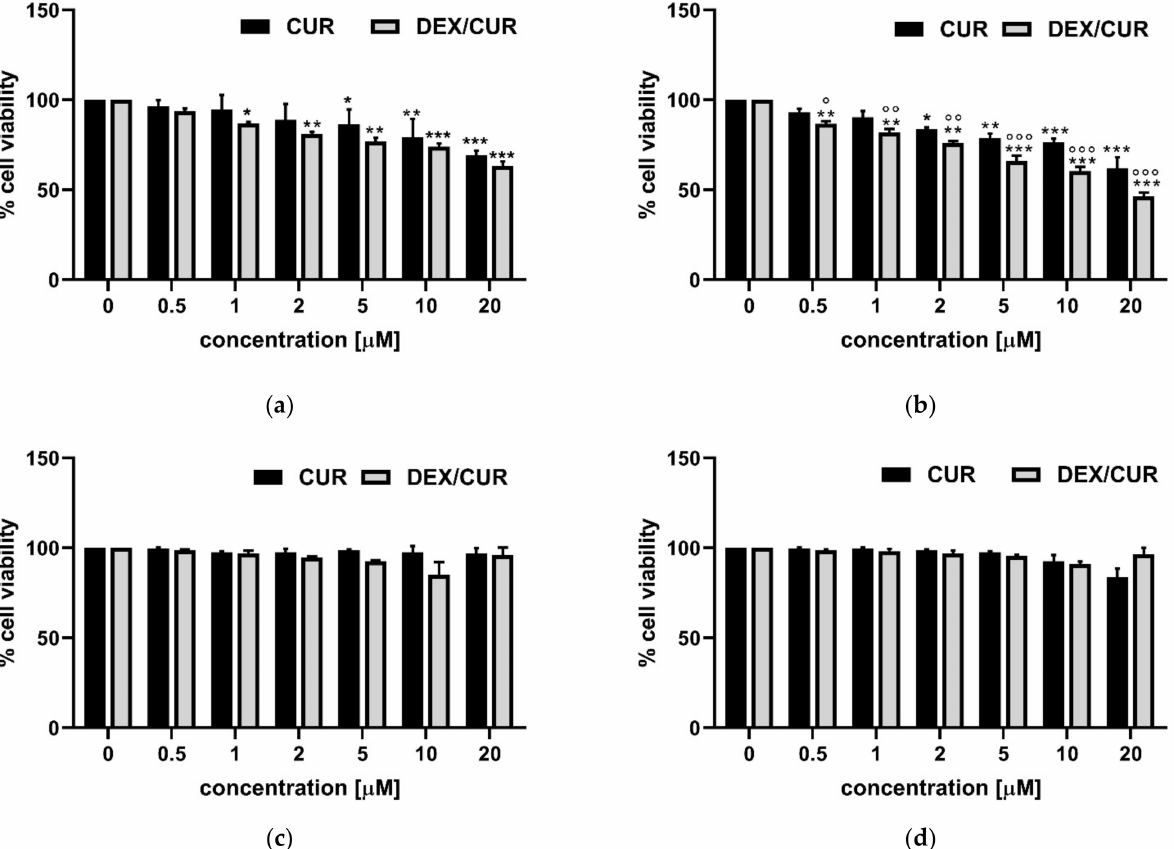
Figure 2. ( a , b ) PC-3 and ( c , d ) PNT-2 viability after ( a , c ) 24 h and ( b , d ) 48 h treatment with CUR (black bars) and DEX/CUR (grey bars). Data were reported as mean values ± SD of three independent experiments. Two-way ANOVA followed by Dunnett’s method: * p < 0.01, ** p < 0.001, *** p < 0.0001 vs. control. ◦ p < 0.01, ◦◦ p < 0.001, ◦◦◦ p < 0.0001 vs. CUR equivalent